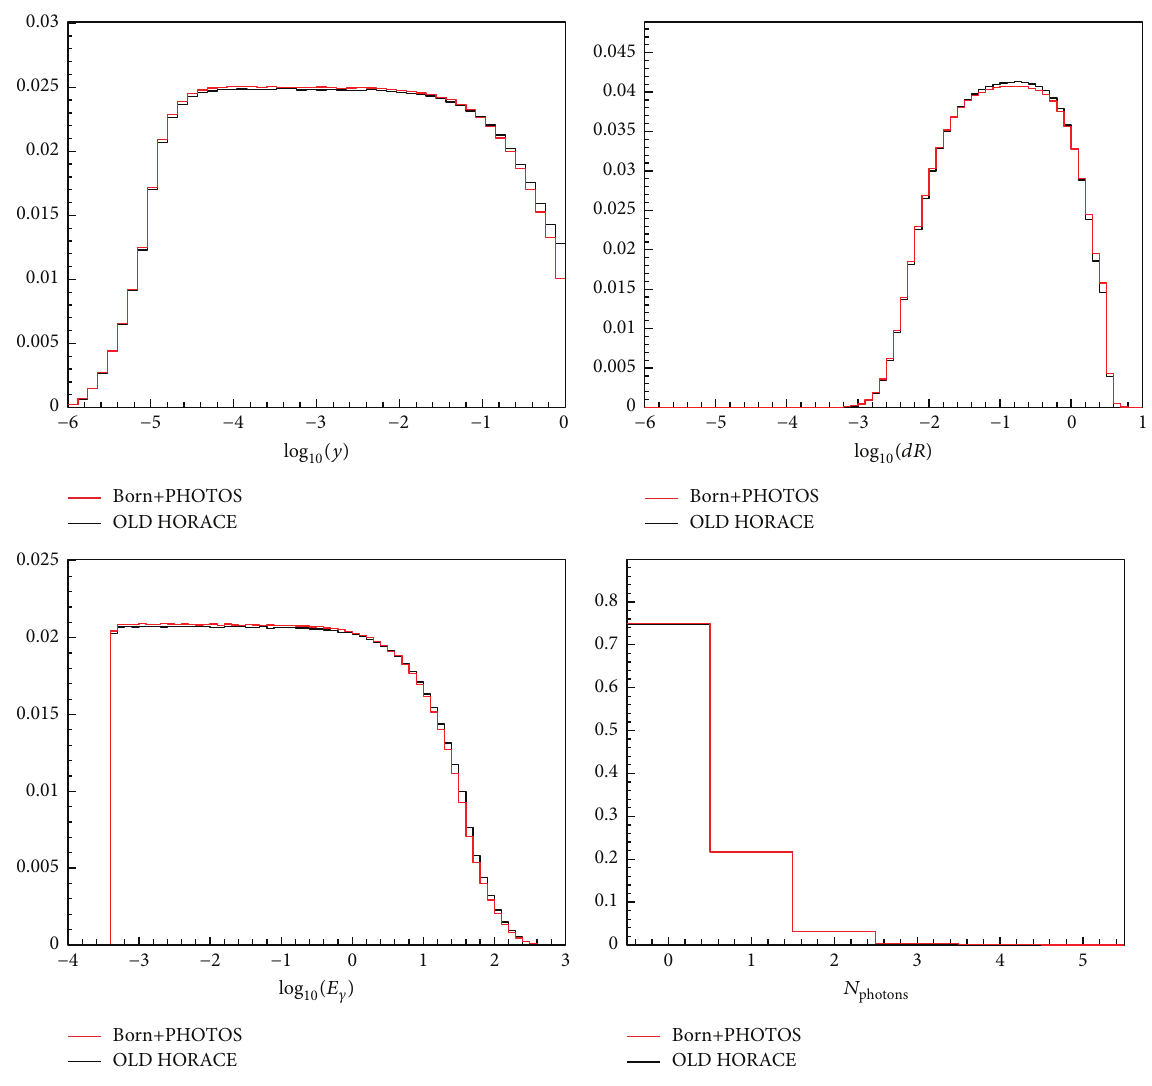
Figure 5: Clockwise from top-left: comparisons of the distributions of log 10 (𝑦 𝛾 ) , log 10 (Δ𝑅(𝑙𝛾)) , 𝑛 𝛾 , and log 10 (𝐸 𝛾 / GeV) for the 𝑊 + → 𝜇 + ] +𝑛𝛾 process between the “Born” mode of old horace interfaced with photos and old horace in the exponentiation mode. The Δ𝑅 is computed with respect to the